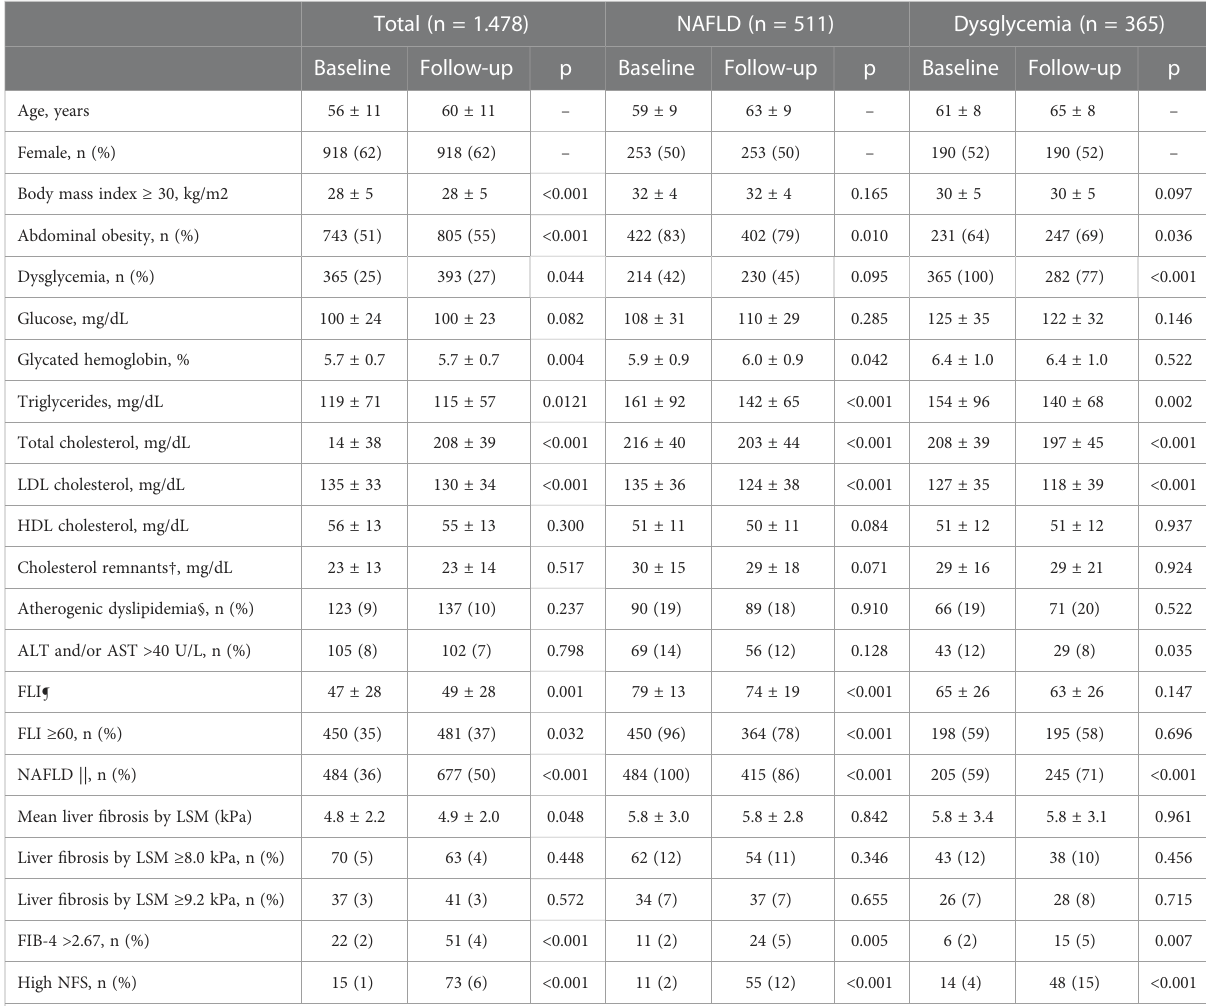
TABLE 1 Characteristics of the study population at baseline and